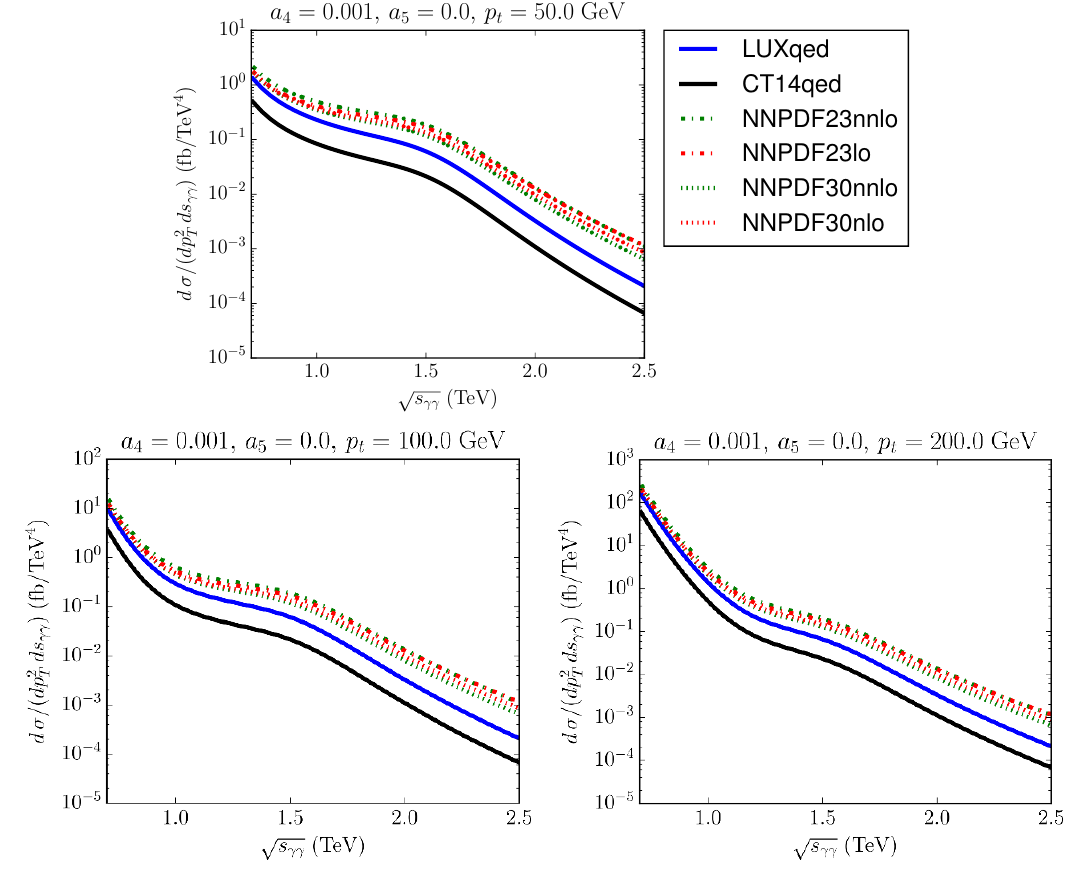
Figure 11 . Same as (cid:12)gure 8 but both protons dissociate in the deeply inelastic regime. Note, by comparing with (cid:12)gure 8, that this can be up to one order of magnitude more likely than elastic scattering. The (e(cid:11)ective) PDF energy scale is (cid:22) 2 = s (cid:13)(cid:13)